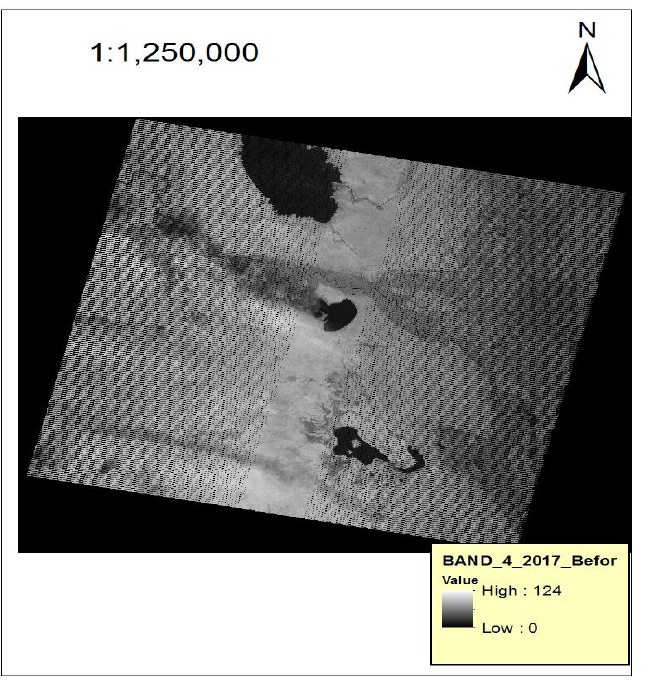
Fig.10: Show image of band (3) in date